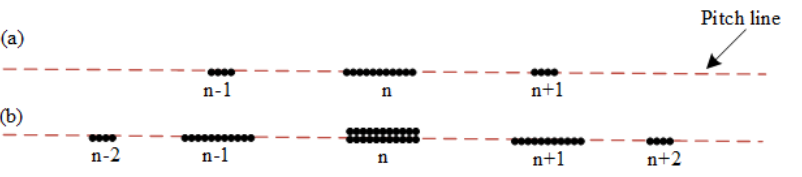
Figure 11. The pitting damage levels from slight to medium on the nth tooth and its neighboring teeth: ( a ) slight pitting fault; ( b ) medium pitting fault.